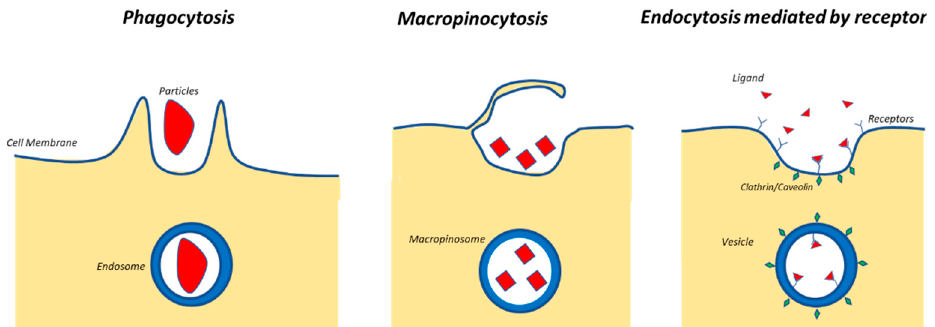
Figure 1. Main types of endocytosis of nanoparticles (NPs).